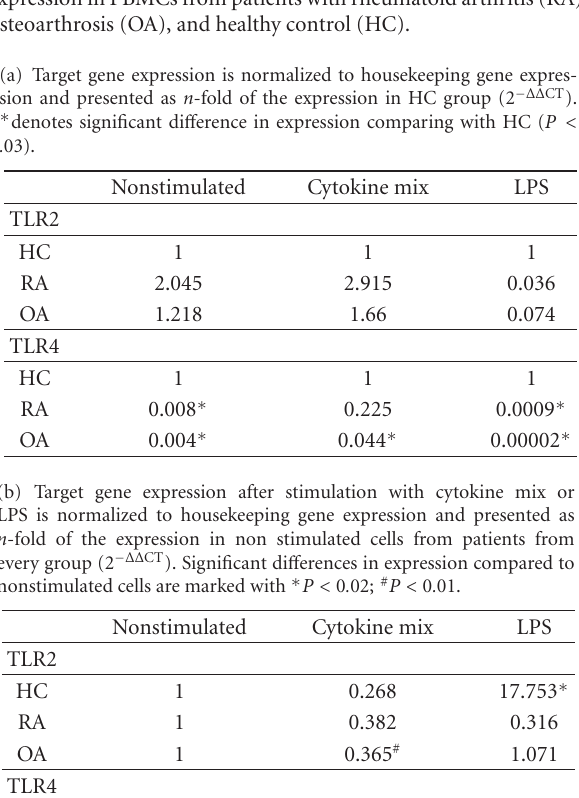
Table 4: Relative quantification of the TLR2 and TLR4 mRNA expression in PBMCs from patients with rheumatoid arthritis (RA), osteoarthrosis (OA), and healthy control (HC).